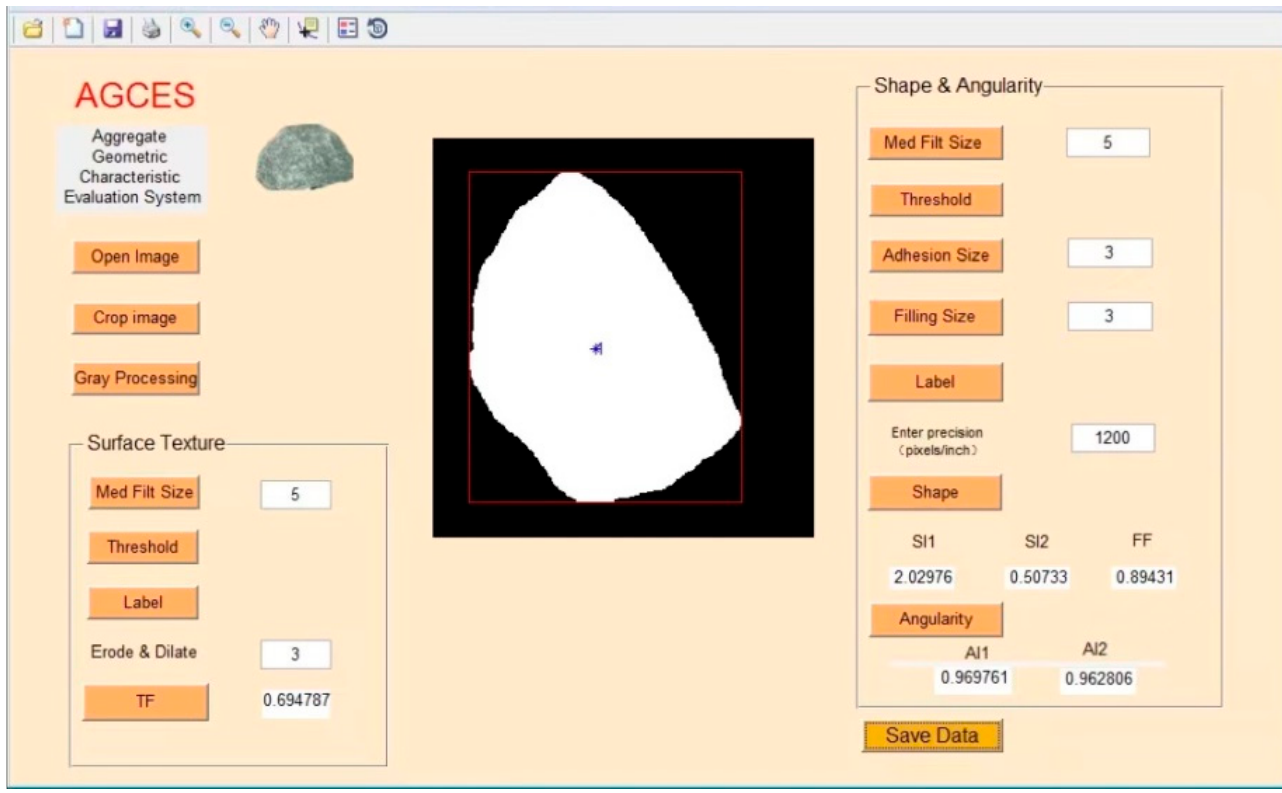
Figure 2. AGCES software interface.